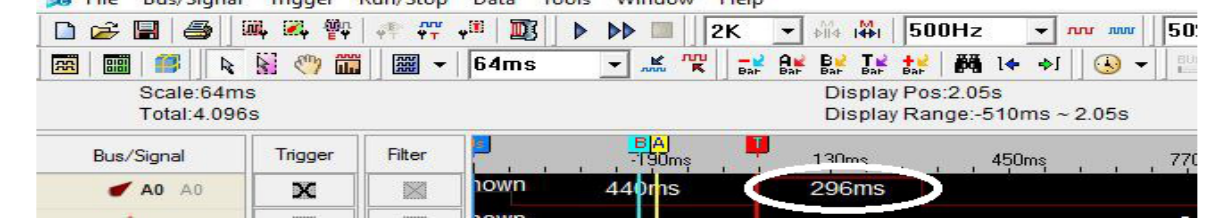
Figure 8. Timing